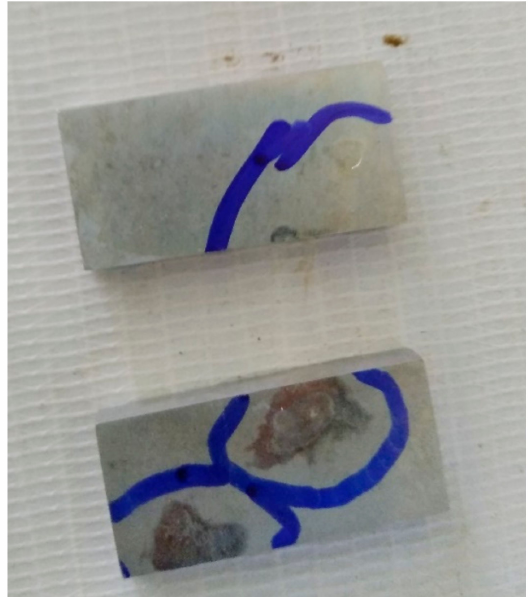
Figure 7. Corroded specimen after immersion